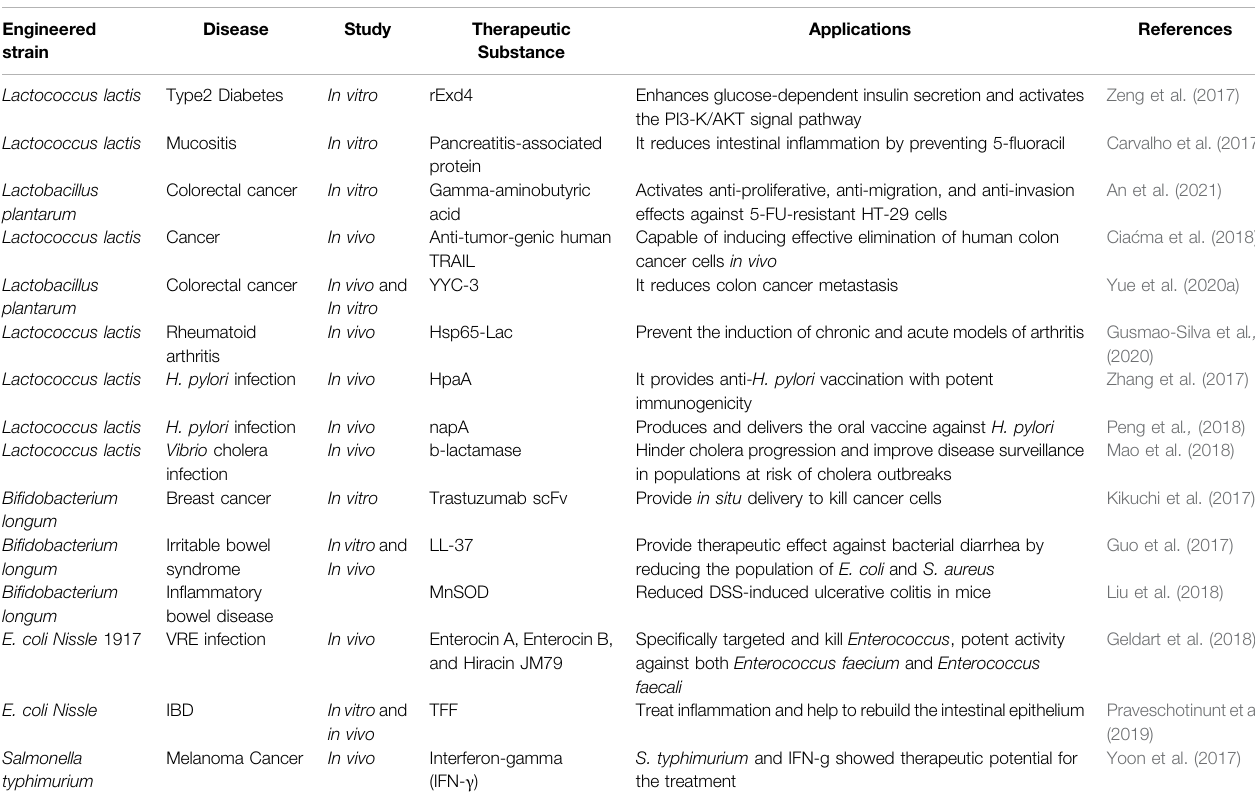
TABLE 2 | Microbial based